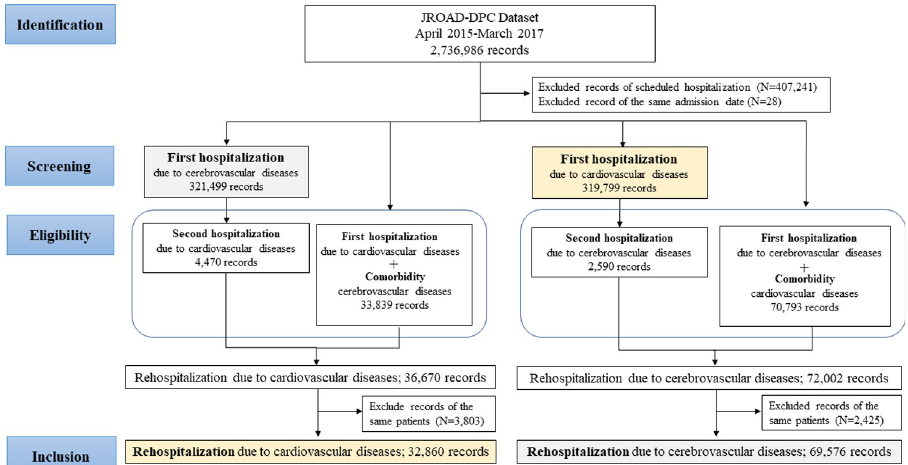
Fig 2. Study flow charts showing analyzes of rehospitalization for cardiovascular and cerebrovascular diseases. AD, aortic dissection; AF, atrial fibrillation; CI, cerebral infarction; HF, heart failure; ICH, intracerebral hemorrhage; JROAD-DPC, Japanese Registry Of All cardiac and vascular Disease-Diagnostic Procedure Combination; MI, myocardial infarction; SAH, subarachnoid hemorrhage.